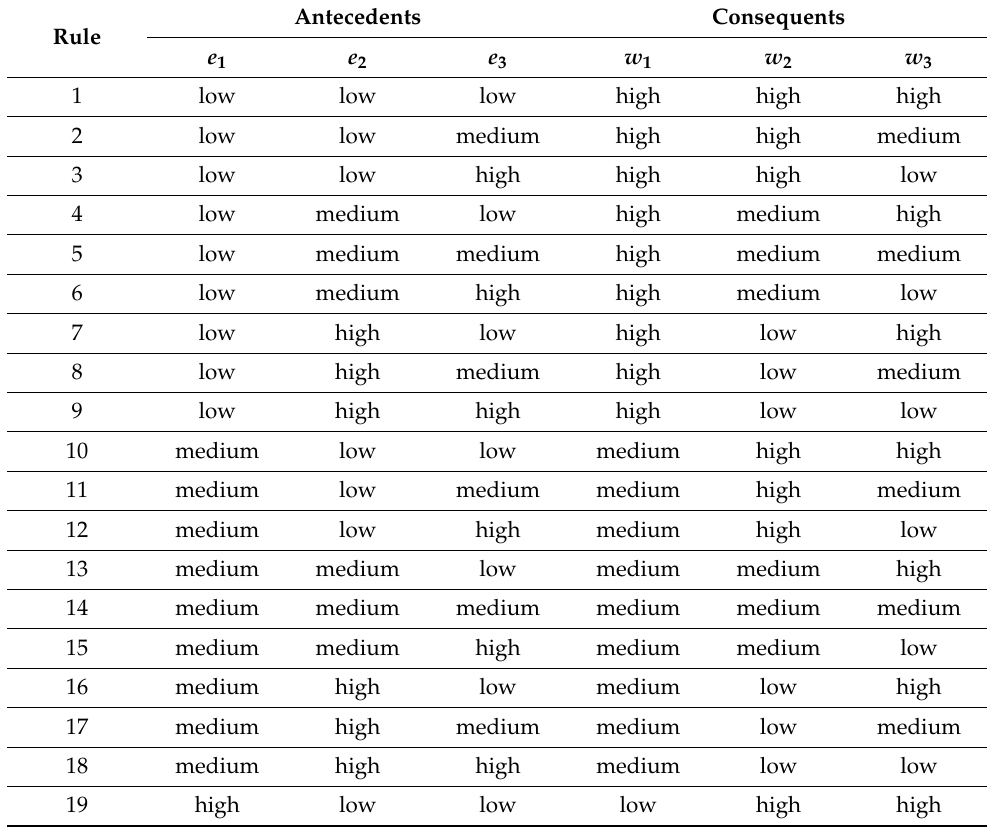
Table 1. Fuzzy if-then rules for three inputs and